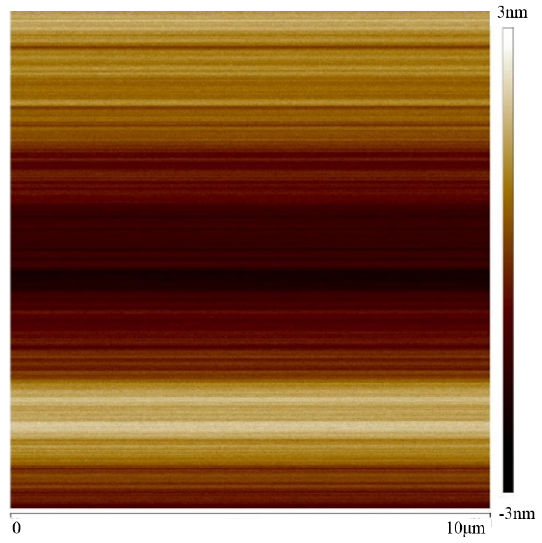
Figure 3. An AFM image of the tested molybdenite surface.